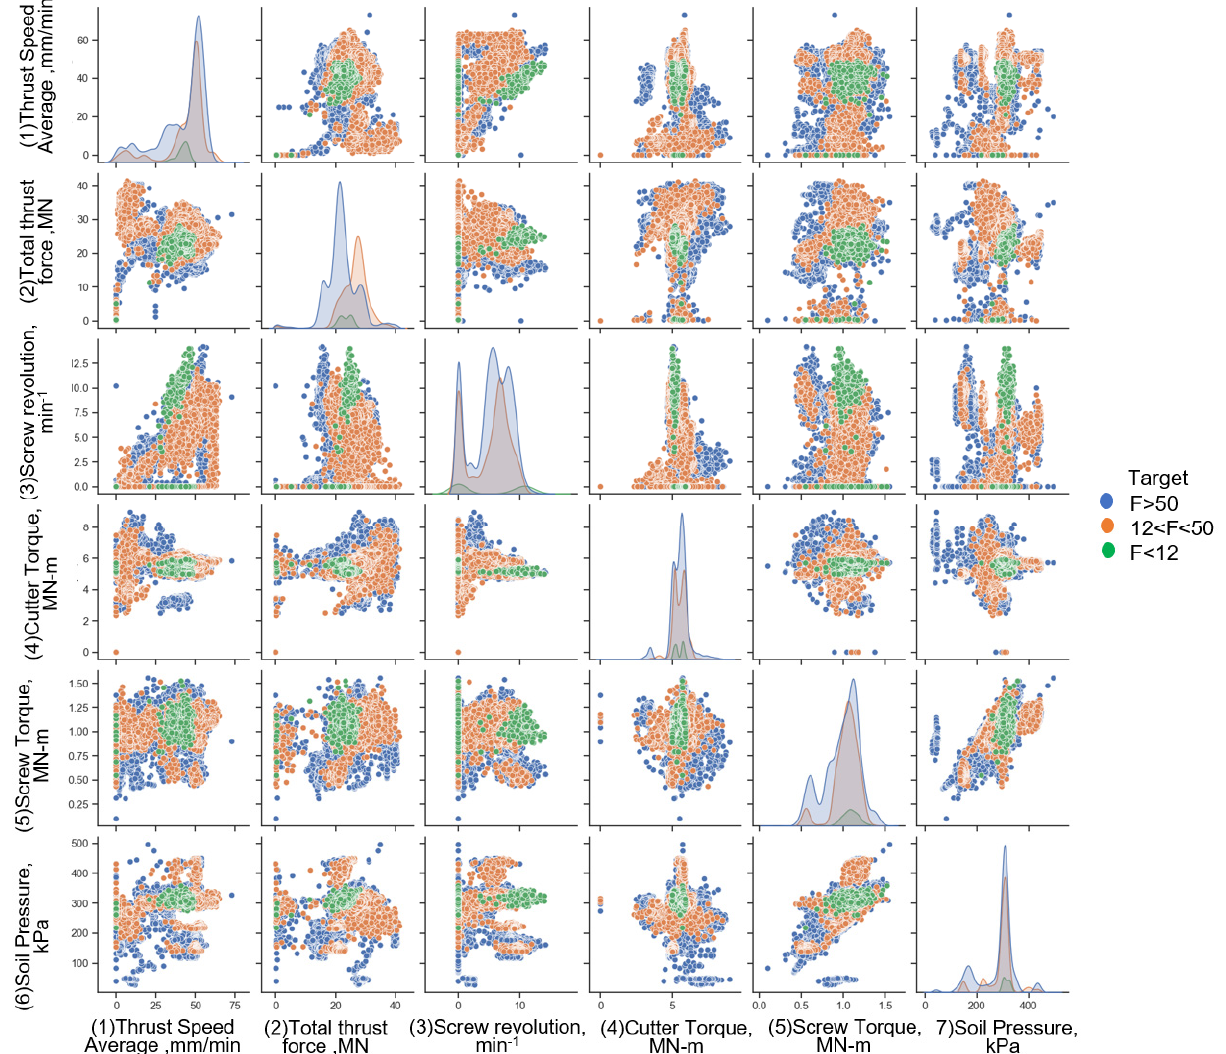
Figure 3. Pair-wise correlations between features of TBM data.